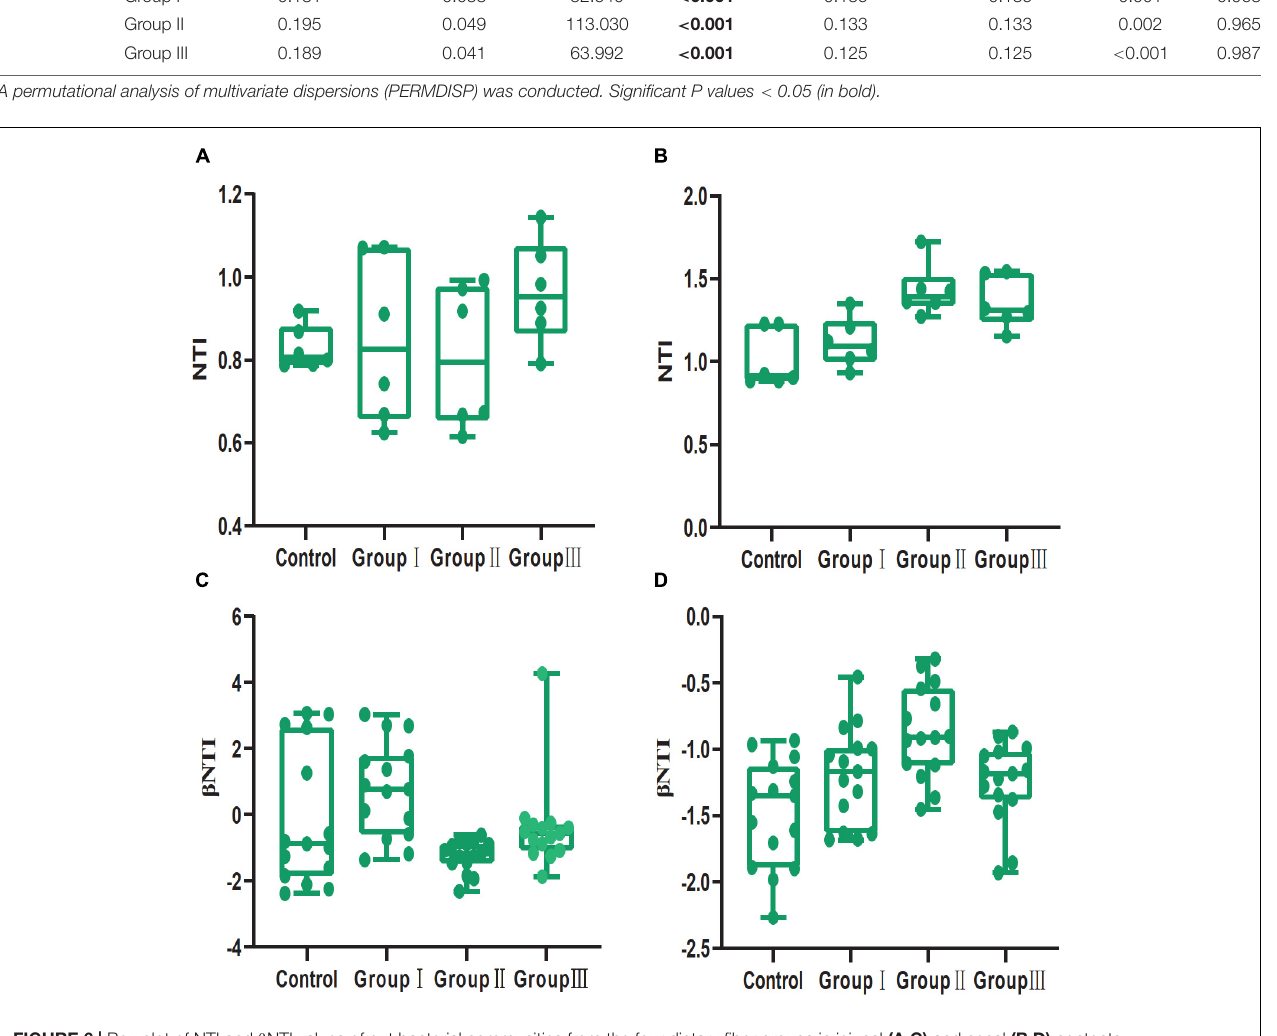
significantly distinct from the null random expectation ( Table 2